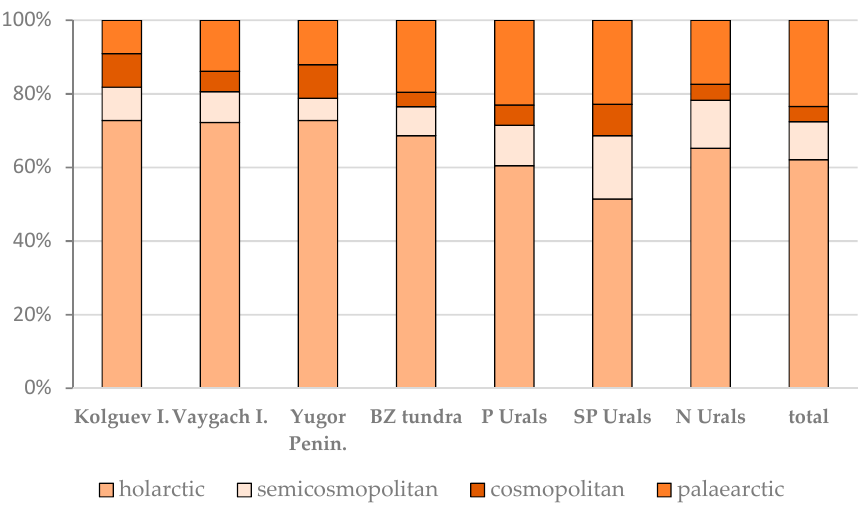
Figure 3. Relative species richness according to the longitudinal distribution of oribatid mites in the local fauna of East European tundra. Kolguev I. – Kolguev Island, Vaygach I. – Vaygach Island, Yugor